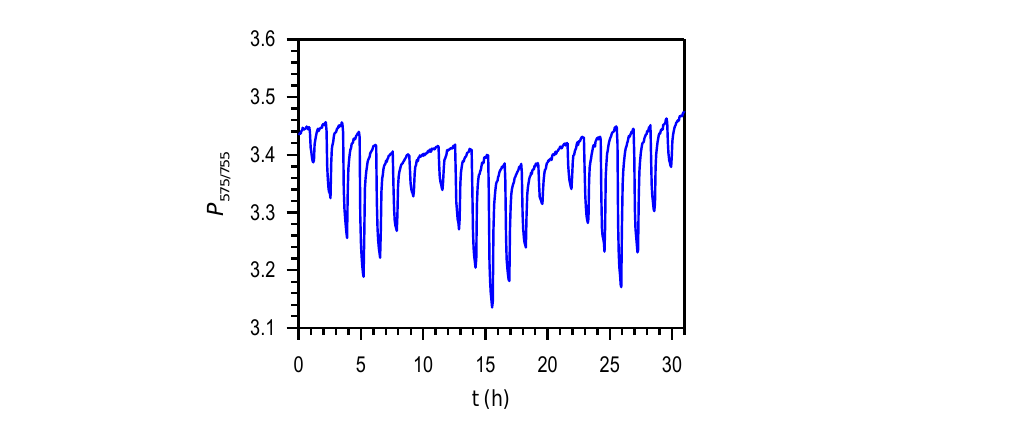
Figure 3. Typical airborne formaldehyde dose-response plot of a manufactured sensitive optical fiber in the 1.5‒7.0 ppmv range (total flow rate 75 mL min ⁻ 1 , atmospheric pressure, 50% RH and controlled temperature (25 ± 1) °C).